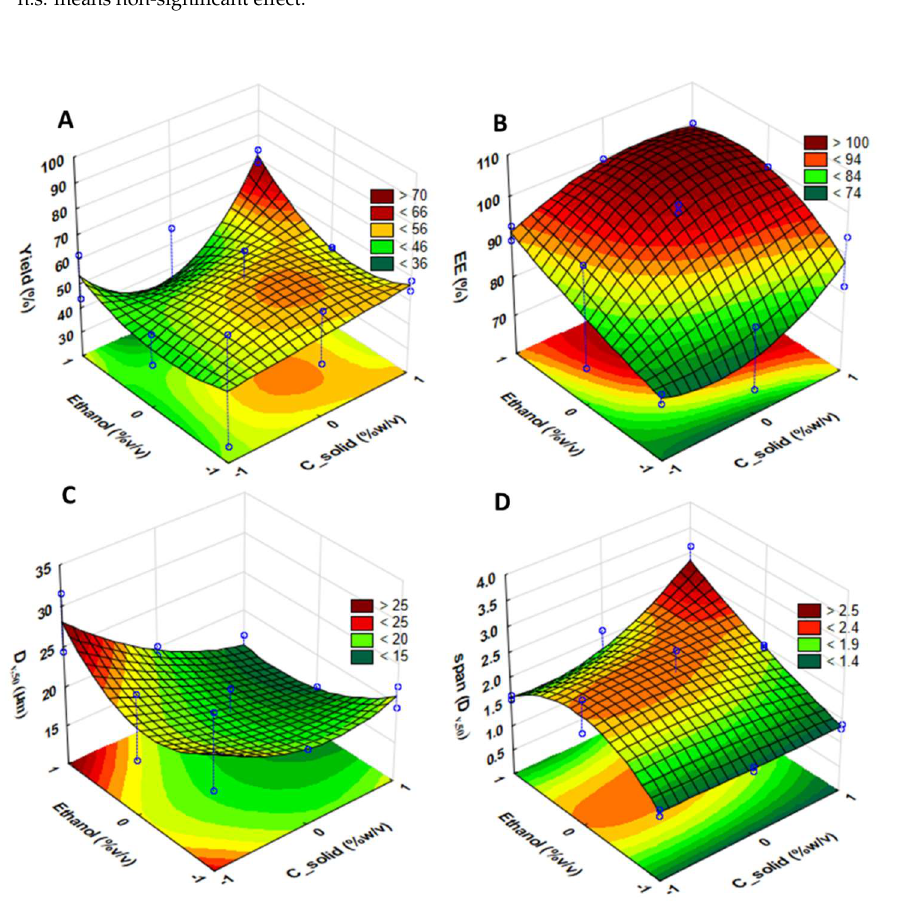
Table 2. Effects component (linear and or quadratic) with p -value obtained from ANOVA for each response studied in RSV–DPFs.